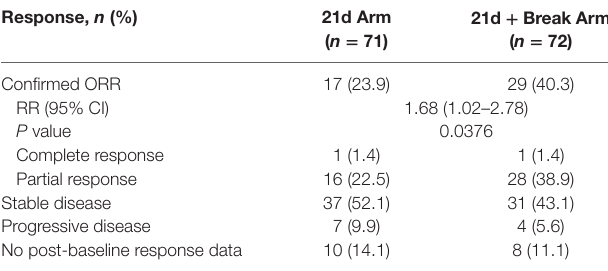
TaBle 5 | Best response to treatment.